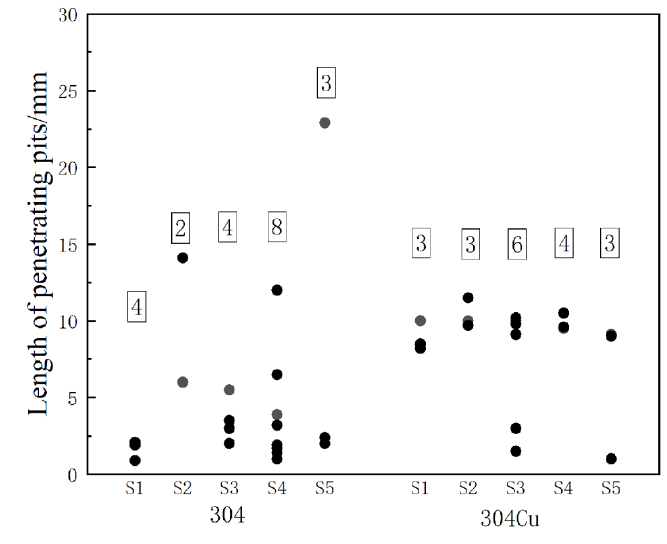
Figure 7. Length of penetrating pits on 304 and 304Cu after immersion in 6 wt.% FeCl 3 for 72 h.